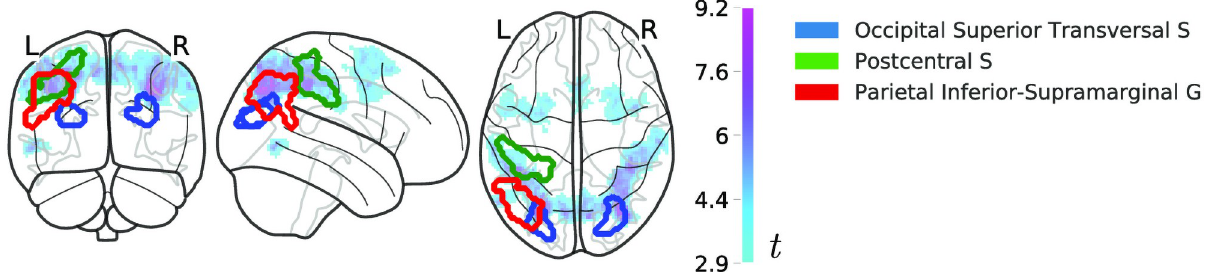
Fig 6. Univariate effects of learning. Statistical map of t -values (magenta-cyan) of the univariate BOLD difference for learned stimuli (repeating/ learned < novel sequences) superimposed on the MNI152 glass-brain template. Regions which encode both novel and repeating sequences as predicted by the recoding model are projected on top of the statistical image with solid lines (red: the parietal inferior-supramarginal gyrus; green: the postcentral sulcus; blue: the occipital superior transversal sulcus).